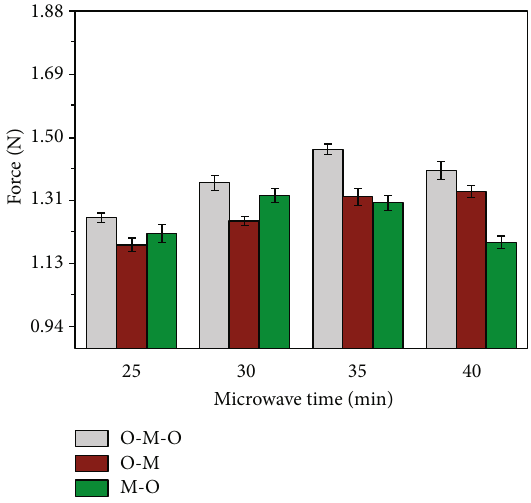
Figure 6: For the hydrogel microneedles dried by microwave- assisted drying, the average value of needle tip breaking force column chart of microwave time was inserted in di ff erent ways (O-M-O, O-M, M-O) under the traditional heating conditions of one hour. The error bar represents the standard deviation of the needle tip breaking force of 10 groups of independent samples repeatedly measured ( n = 10